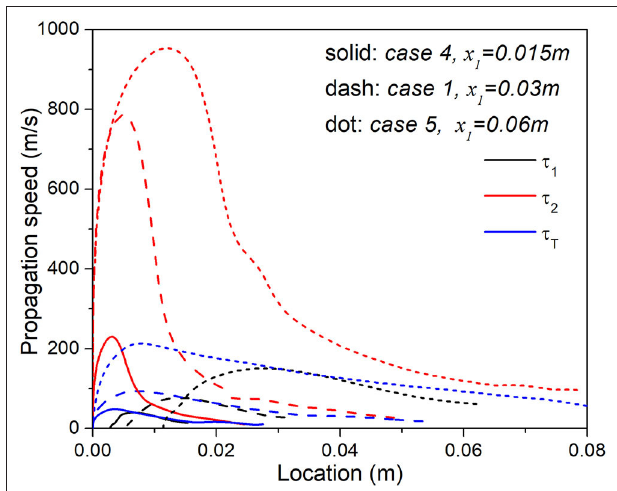
FIGURE 6 | Comparison of the propagation velocity of each heat release peak in Case 1, 4, and 5 with the same temperature range but different lengths of stratification